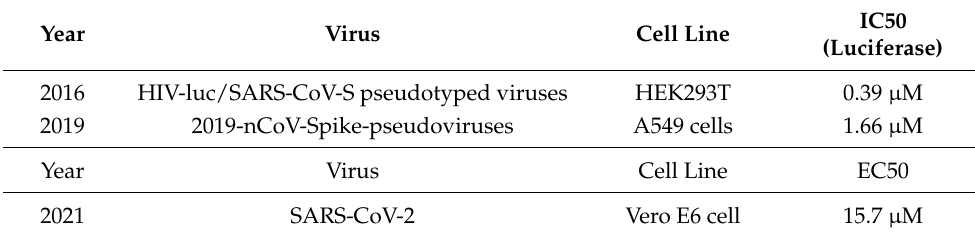
Table 4. Teicoplanin effect on SARS-CoV1 and